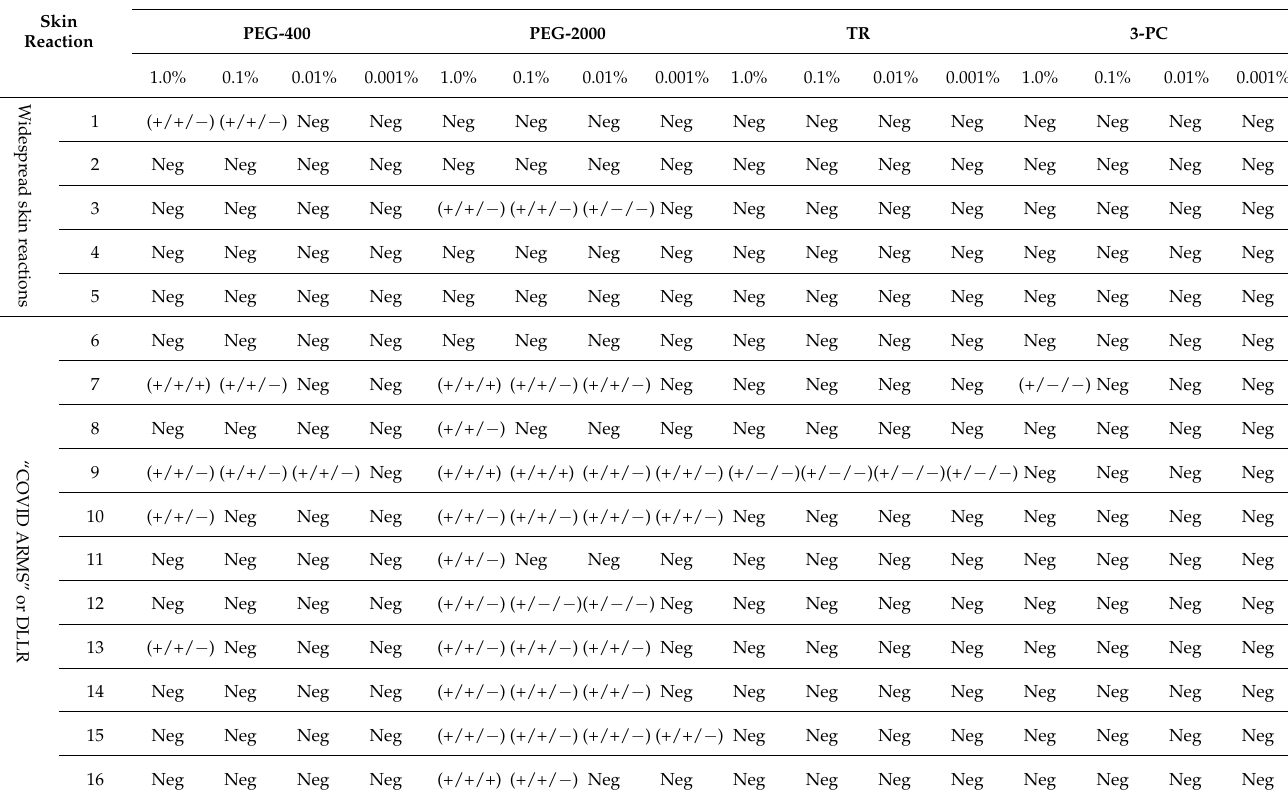
Skin testing of DLLR versus widespread reactions. Abbreviations: (+): positive; ( − ): negative; PEG: polyethylene glycol; TR: trometamol; 3-PC: 1,2-dimyristoyl-sn-glycero-3-phosphocholine; D2: Day